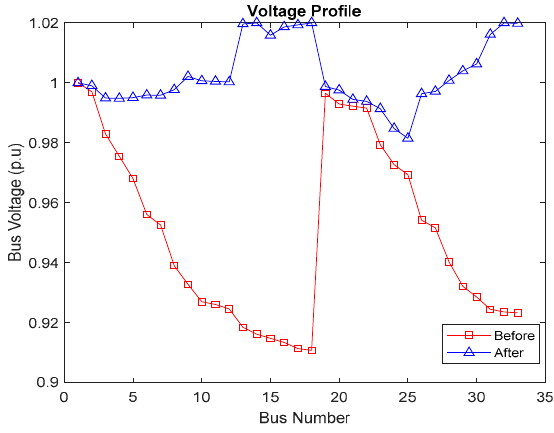
Figure 3. Voltage profile improvement in case V.